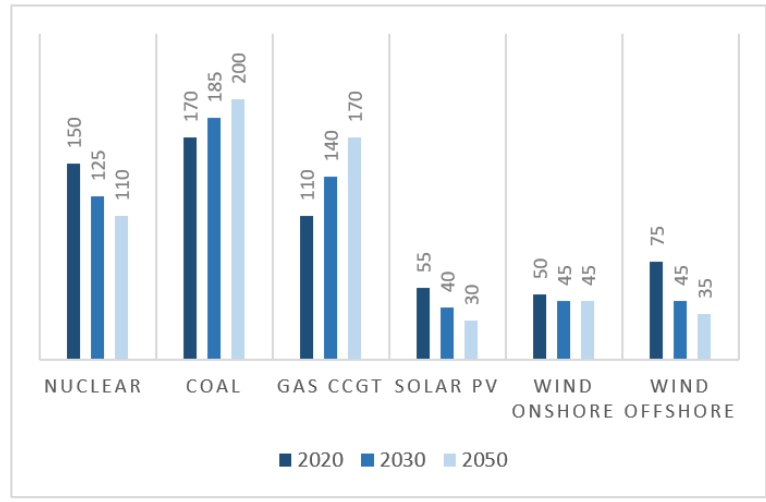
Figure 1. Levelized cost of electricity (USD/kWh) in European Union in the Stated Policies Scenario [5].